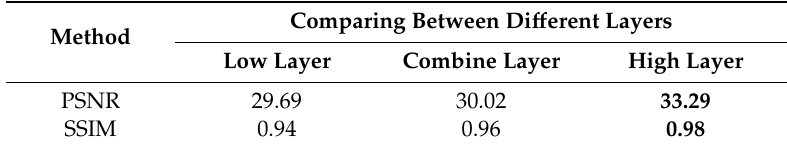
Table 5. PSNR and SSIM of di ff erent layer on GOPRO Large dataset.